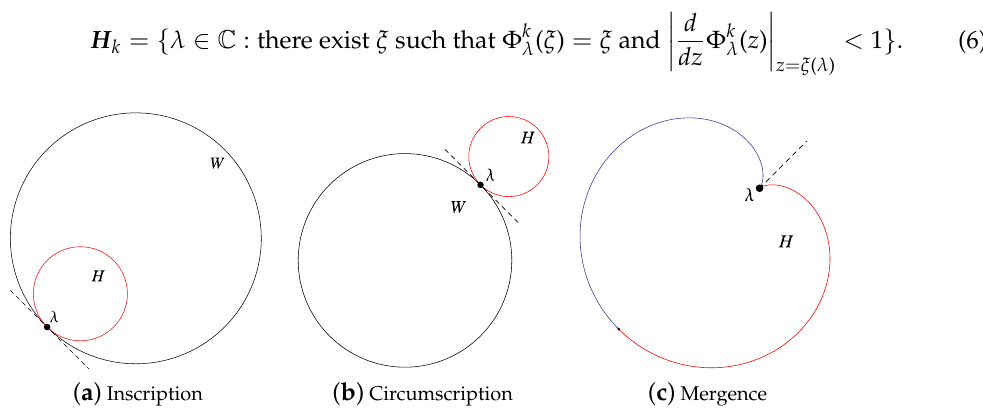
Figure 1. Typical bifurcation geometries for budding components.